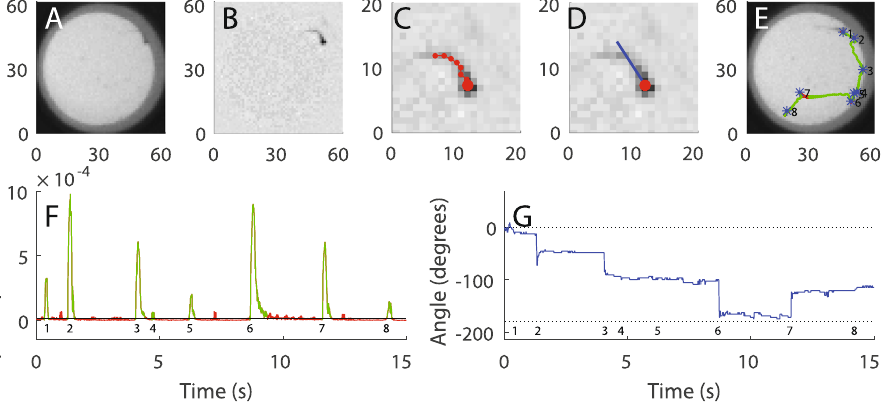
Figure 1. Automated procedures reveal detailed kinematics of the highly discretized swimming behavior. ( A ) Example image frame from high-speed video recording of spontaneous swimming behavior. Each of the 48 larvae, recorded in parallel, is kept isolated in a 15 mm well (red pixels overlaid in the gray scale image denote the body of the larva as automatically classified by the system). ( B ) The corresponding image as shown in ( A ) after background subtraction of pixels lacking temporal dynamics. ( C ) Close-up of the foreground image with superimposed tracking data, where the large dot marks the putative head. Note the improved contrast compared to ( A ) following background subtraction. (D) Estimated gross body orientation in the horizontal plane generated by the system is marked by overlaid blue line. ( E ) Example episode of spontaneous swimming illustrated by the tracked trajectory of the head position during a 15 s time interval (first frame in the sequence is shown as background). The trajectories of single swimming bouts are colored in green. The blue asterisks represent the starting point of each detected bout during the 15 s period (numbered from 1 to 8; red pixels mark a section of the trajectory where movement speed was below the threshold used for classification of swimming behavior and thus not considered part of a bout). ( F ) Swimming speed plotted as a function of time for the 15 s period shown in ( E ), [numbering of individual bouts as in ( E ); only swimming episodes with a speed above threshold level (black line) above a minimum duration were classified as bouts (#1–8)]. Note that there are some time intervals that are not classified as swim bouts even though the estimated movement speed is larger than the threshold. This is because of the removal of intervals shorter than 0.03 s. ( G ) Allocentric head angle (East = 0 degrees) plotted as a function of time during the 15 s period shown in ( E ). Bout numbering as in ( E,F